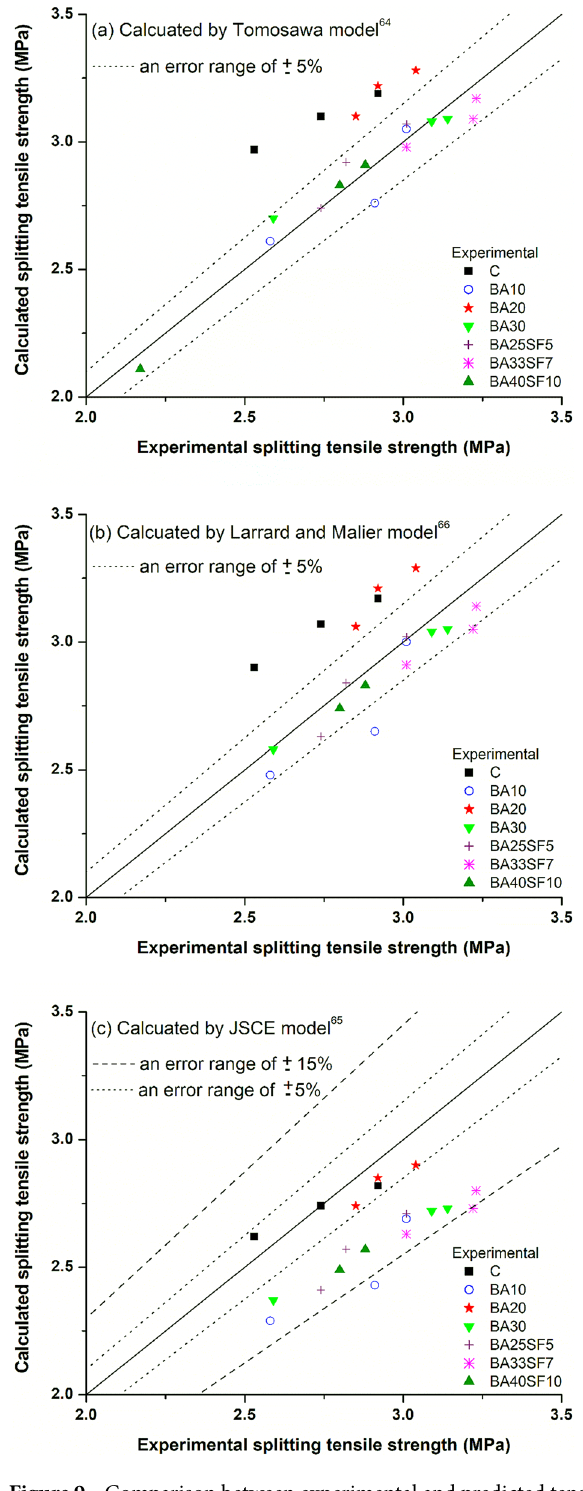
Figure 9. Comparison between experimental and predicted tensile strength